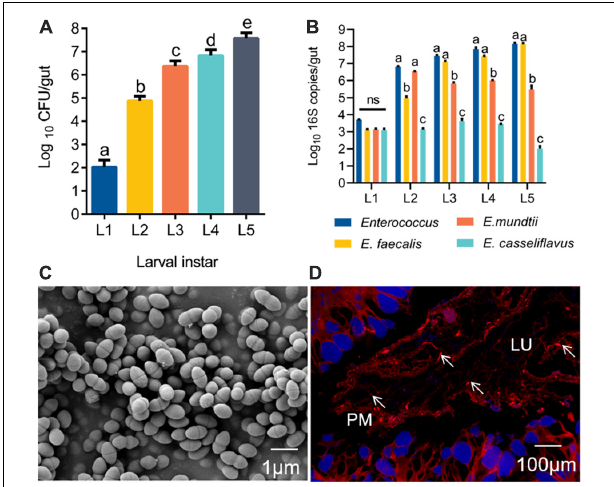
FIGURE 1 | Enterococcus is widely found in the gut of silkworms. (A) Change in the Enterococcus population in the gut microbiota of B. mori larvae across different instars (L1, first instar; L2, second instar; L3, third instar; L4, fourth instar; L5, fifth instar). Proportional data are modeled using the mean number of CFUs counted ( n = 10). (B) Absolute quantification (qPCR) of the total Enterococcus , Enterococcus faecalis , Enterococcus mundtii , and Enterococcus casselifavus 16S gene numbers in gut samples (L1-L5; mean with 95% confidence intervals). (C) Scanning electron microscopy (SEM) images of E. faecalis . Scale bars are 1 µ m. (D) FISH with a Cy3–labeled E. faecalis -specific probe (red) shows a high density of bacterial cells adhered to the peritrophic membrane. lu, gut lumen; pm, peritrophic membrane; epithelium (blue, nuclei stained with DAPI). Statistically significant changes were determined by ANOVA and the post hoc Tukey honestly significant difference (HSD) test. Different letters represent statistically significant differences ( p < 0.05, n =